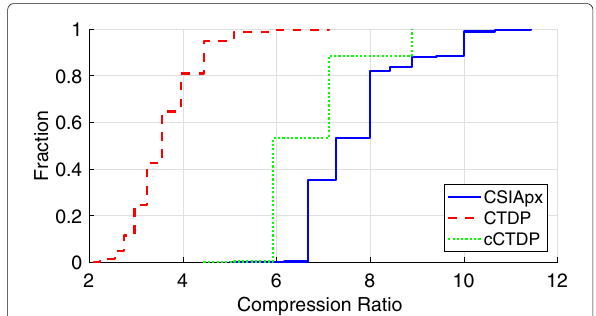
Fig. 6 Compression ratio with experimental data. A comparison of the cumulative density function (CDF) of the compression ratio achieved when running CSIAPx versus CTDP versus CCTDP